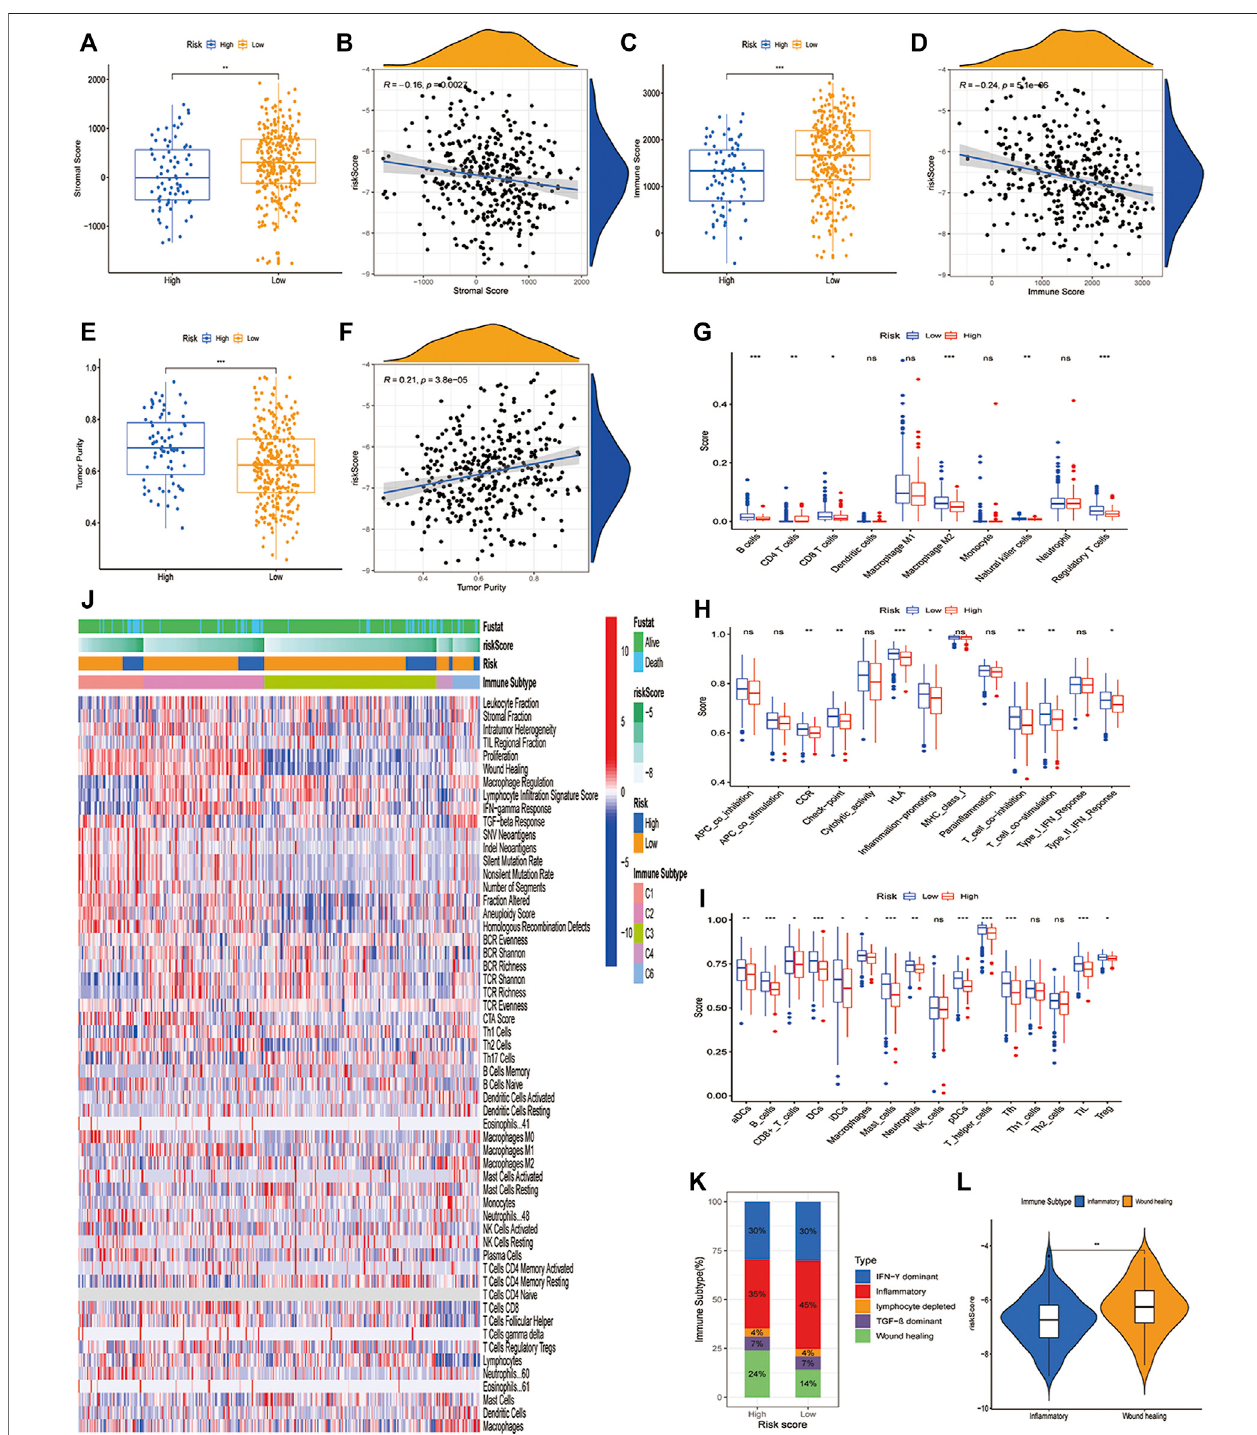
FIGURE 5 | The immune landscape of PCD-related signature in LUAD. (A,B) Signi fi cant differences of stromal score in high- and low-risk groups and correlation with risk score. (C,D) Signi fi cant differences of immune score in high- and low-risk groups and correlation with risk score. (E,F) Signi fi cant differences of tumor purity in high- and low-risk groups and correlation with risk score. (G) Comparison of 10 types of immune cells in high- and low-risk groups through CIBERSORT. (H,I) Comparisonof16typesofimmunecellsand13immune-relatedpathwaysinhigh-riskandlow-riskgroupsthroughssGSEA. (J) Theheatmapshowingdifferentcell type panels in different immune subtypes of lung cancer. (K) Estimated immune subtype proportion in high-risk and low-risk groups. (L) Comparison of the risk score in in fl ammatory subtype and wound healing subtype. (*, **, ***, and **** represent p < 0.05, p < 0.01, p < 0.001 and p < 0.0001, respectively).